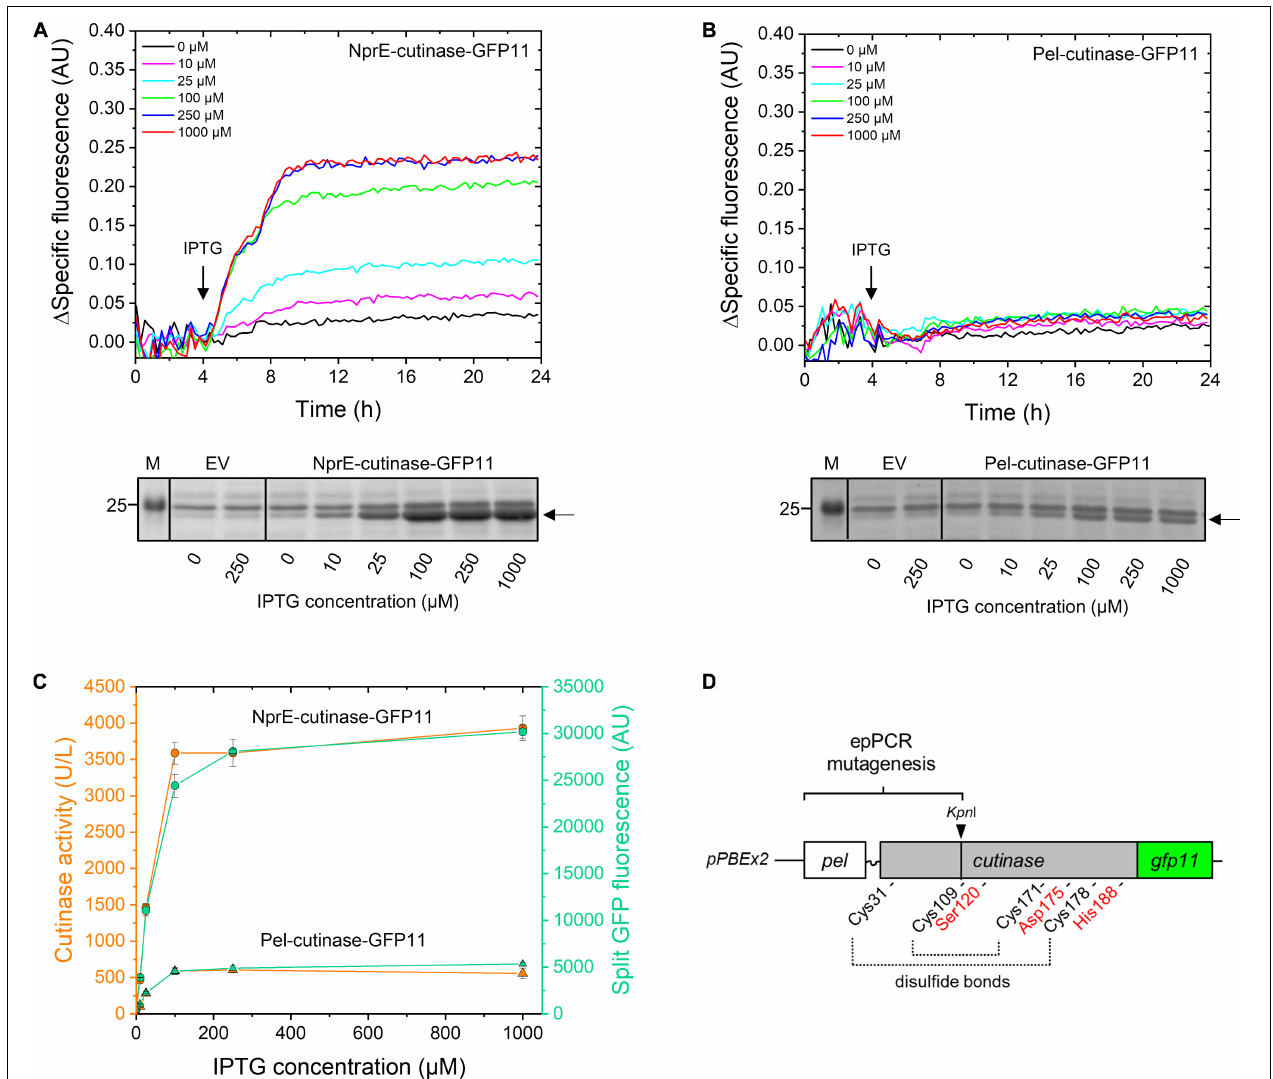
FIGURE 2 | Monitoring the secretion of GFP11-tagged cutinase using the C. glutamicum K9 biosensor strain and the split GFP assay. C. glutamicum K9 biosensor cells harboring pPBEx2 (EV), pPBEx2-NprE-cutinase-GFP11 or pPBEx2-Pel-cutinase-GFP11 were grown in CGXII medium containing 1% (v/v) glucose in a BioLector for 24 h at 30 ◦ C, 1,200 rpm and 85% relative humidity. Four hours after inoculation, IPTG was added to the cultures to indicated final concentrations. The fluorescence response of the biosensor cells during cultivation is shown in the upper panels as the (cid:49) specific fluorescence over time for cells expressing NprE-cutinase-GFP11 (A) or Pel-cutinase-GFP11 (B) . Cutinase-GFP11 in the respective culture supernatants after 24 h of growth was analyzed by SDS-PAGE (lower panels). The proteins were visualized by Coomassie Brilliant Blue staining. EV; C. glutamicum K9 biosensor cells harboring pPBEx2 (empty vector). The arrows indicate the position of the processed (signal peptide-less) cutinase-GFP11 (expected size 25.1 kDa). M, marker proteins with Mw indicated in kDa. (C) In parallel, culture supernatants were analyzed for cutinase activity and split GFP fluorescence. (D) Schematic view of the epPCR mutagenesis range, which spans the Pel SP , the linker region and a substantial portion of the mature N-terminal part of the cutinase gene up to the unique internal Kpn I restriction site. Positions of amino acids important for cutinase activity are indicated; i.e., the catalytic triad Ser120-Asp175-His188 and the four cysteines involved in disulfide bond